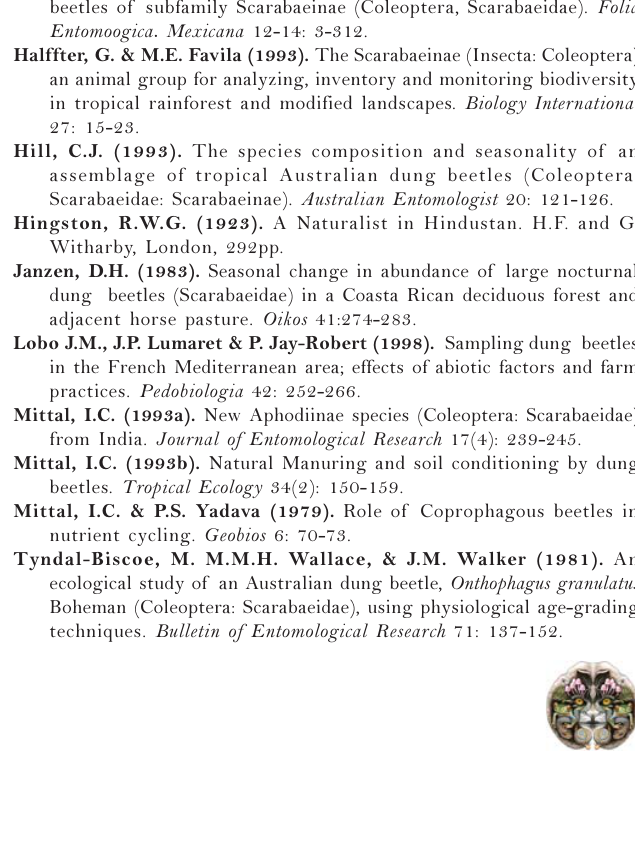
Table 1. Proportional abundance of different